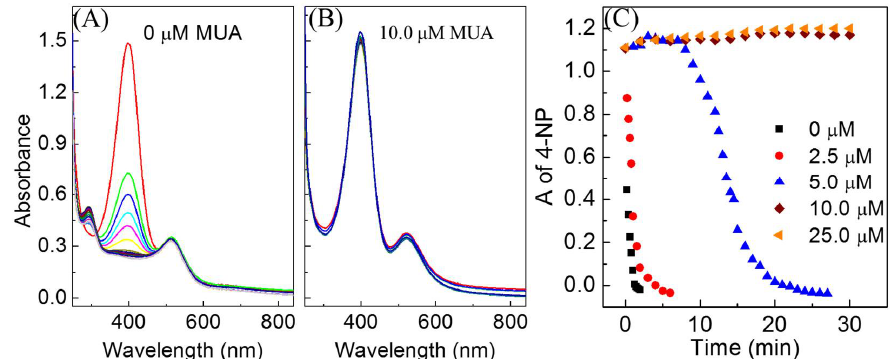
Figure 4. Catalytic activity of AuNP-MUA as function of MUA packing density on AuNPs. ( A ) Time-resolved UV-VIS spectra of 4-nitrophenol (4-NP) reduction reaction catalyzed by AuNPs functionalized with 0 µM MUA; ( B ) Time-resolved UV-VIS spectra of 4-nitrophenol reduction reaction catalyzed by AuNPs and functionalized with 10 µM MUA; and ( C ) The progress of the reaction tracked by the change in 4-NP absorbance peak at 400 nm over the time.